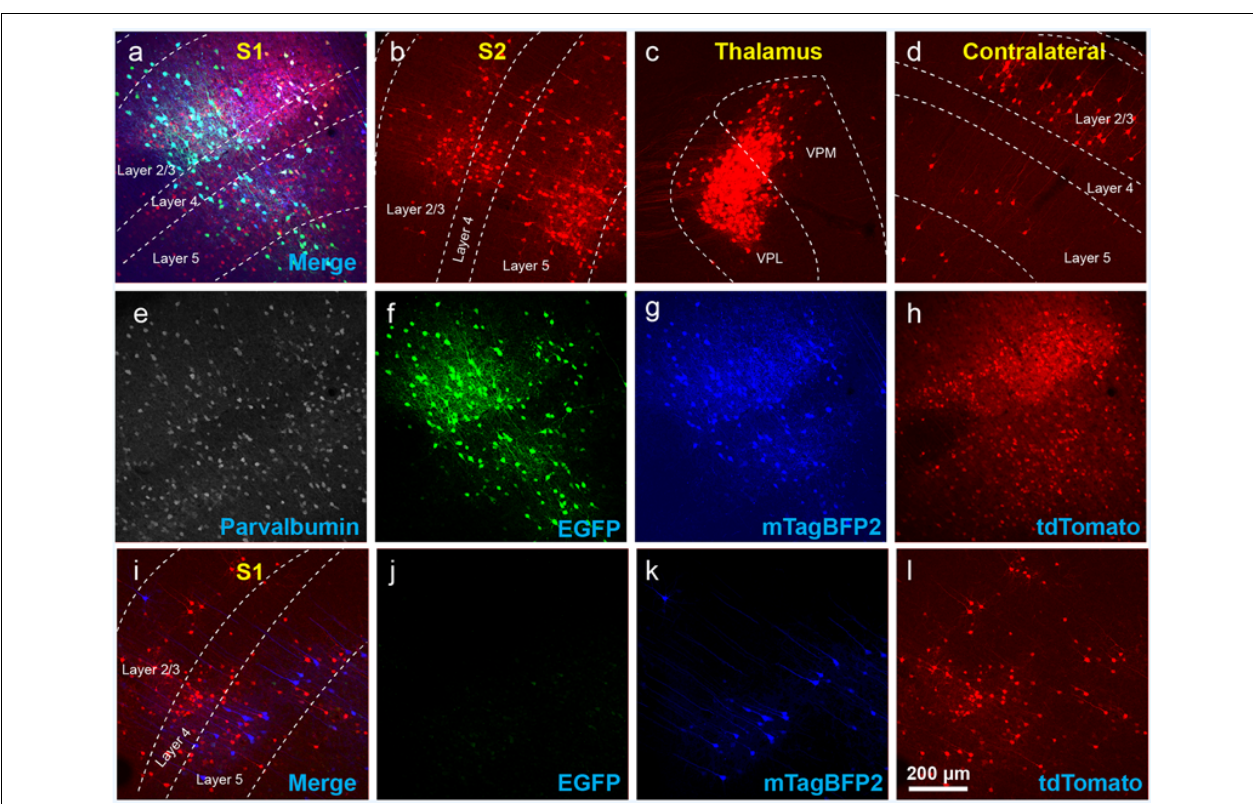
FIGURE 3 | The use of insufficiently-diluted helper viruses results in excessive background labeling in Cre-negative animals. (A–H) Diluting the helper viruses to concentrations matching previously used preparations gave much better results. (A) Injection site in S1; individual channels from this field are shown in panels (E–H) . (B–D) Many labeled presynaptic neurons were found in ipsilateral secondary somatosensory cortex (B) , ipsilateral thalamus (VPL and VPM; C ), and contralateral S1 (D) . (E) Anti-parvalbumin staining (not shown in panel A ). (F) Anti-EGFP staining, indicating expression from the first, Cre-dependent AAV. (G) mTagBFP2, indicating expression from the second, G-encoding AAV. (H) tdTomato, reporting activity of the FLPo-encoding RV. (I–L) Even with the AAVs diluted to match the titers of previous batches, excessive background labeling is seen at the injection site. (I) Overlay of (J–L) . (J) Anti-EGFP staining, (K) mTagBFP2 signal, (L) tdTomato marking RV labeling. Scale bar in (A) : 200 µ m, applies to all